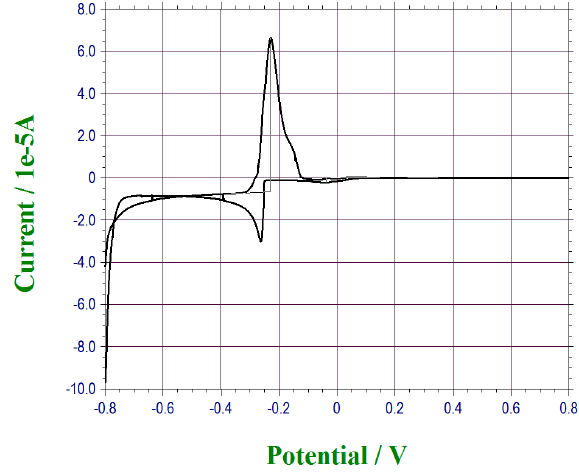
Figure 1. Cyclic voltammetry for the full range of scanning for bismuth reaction potential.